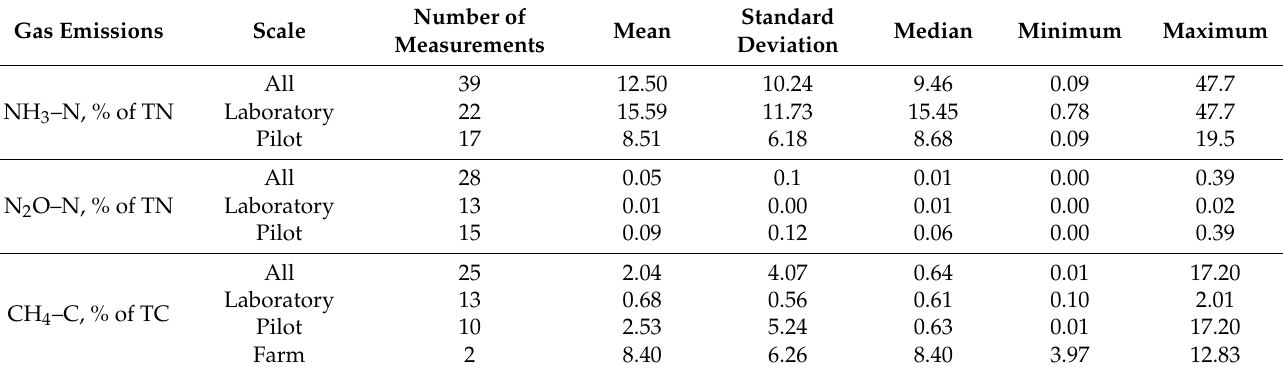
Table 3. Reported NH 3 –N, N 2 O–N and CH 4 –C emissions from dairy slurry storage from studies conducted at laboratory, pilot and farm